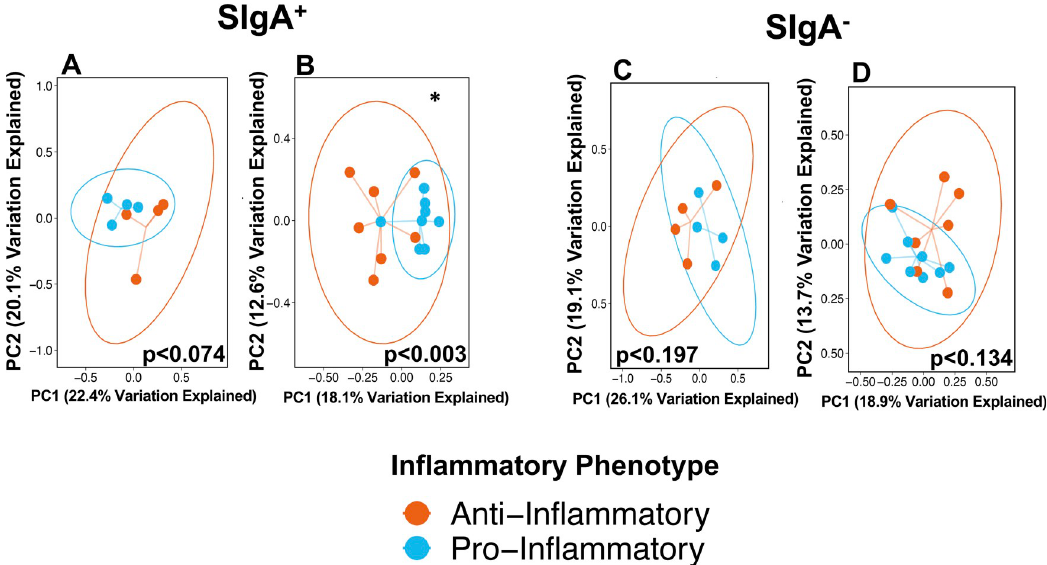
Fig 7. Principal coordinate analyses of UniFrac distances of the stool IgA-Biome by Th17:Treg ratio-derived inflammatory phenotypes across diabetes status. Principal coordinate analyses of unweighted UniFrac distances of the ( A, B ) SIgA + and ( C, D ) SIgA - compartments of individuals with differing inflammatory profiles. ( A, C ) Normoglycemic and ( B, D ) dysglycemic. Statistical significance was determined using PERMANOVA adjusted for body mass index; � p < 0.003.